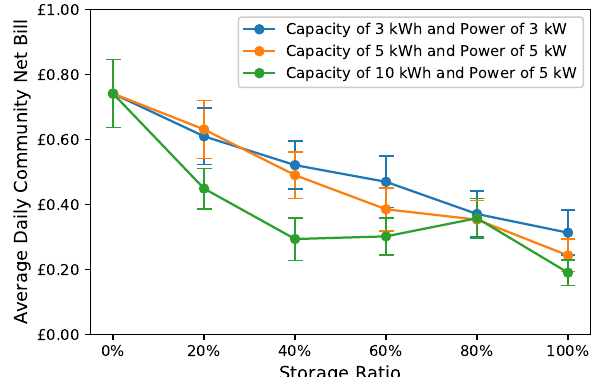
for the simulations with perfect predictions with storage. The average daily Figure 7. Average daily B C K deficit was reduced by increasing the ratio of prosumers with storage or by increasing the storage B C K capacity in the community.